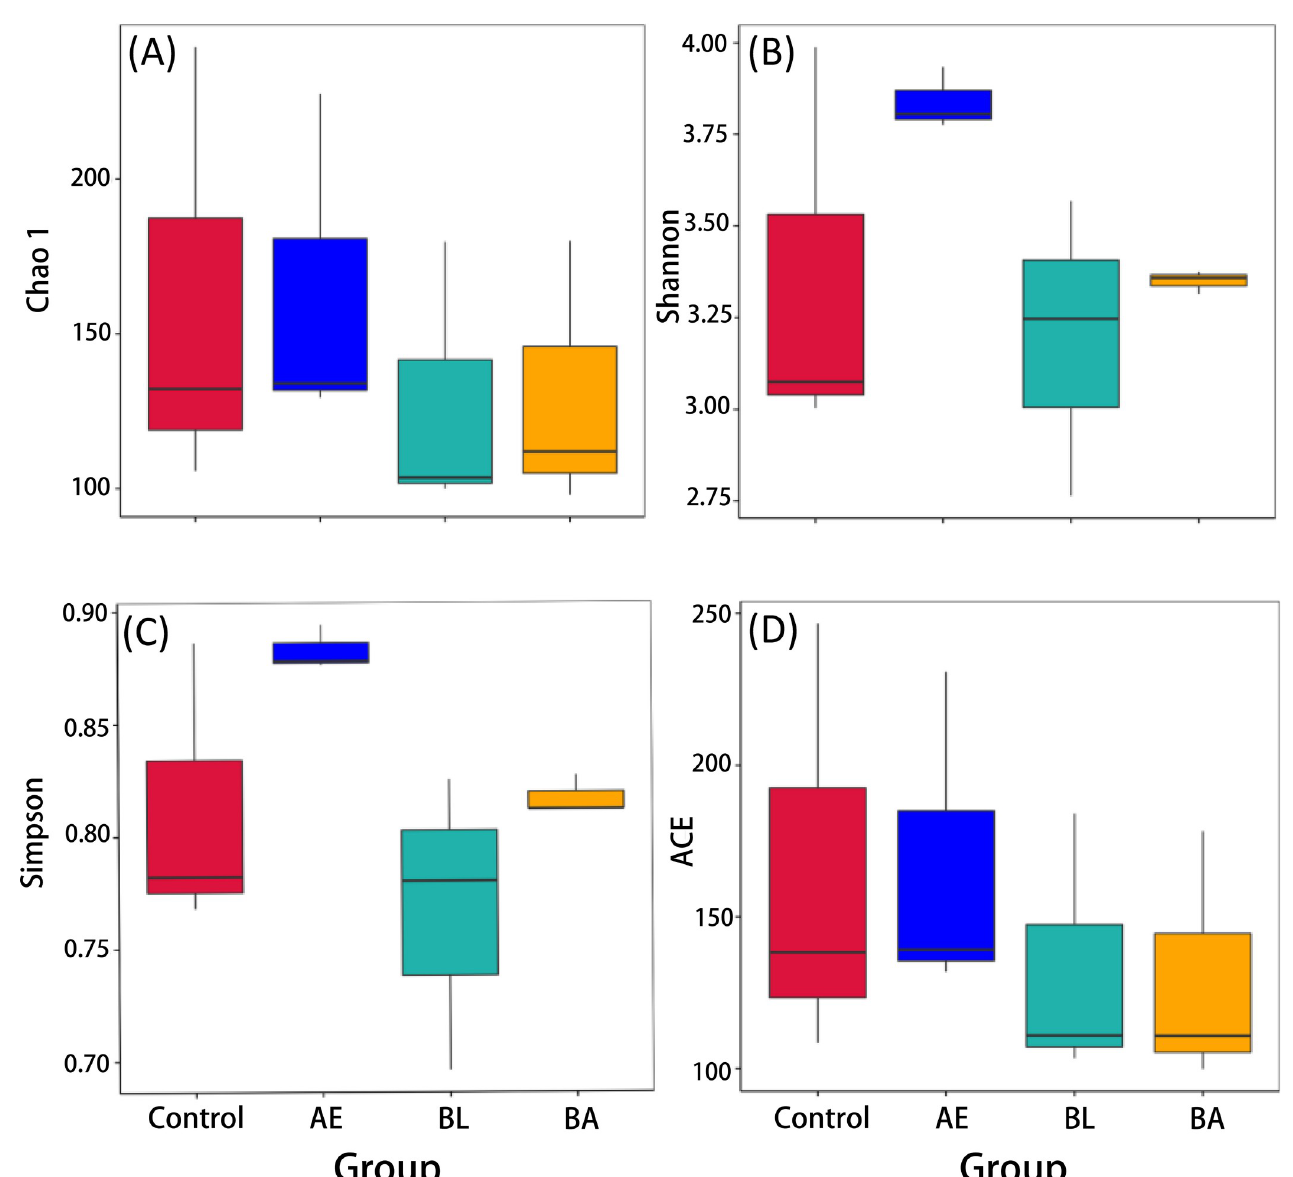
Fig 4. Gut microbiota diversity indices of InR [E19] /TM2 D . melanogaster in the four groups. AE: Astragalus membranaceus extract, BL: Bacillus licheniformis and BA: Bacillus licheniformis and Astragalus membranaceus extract.